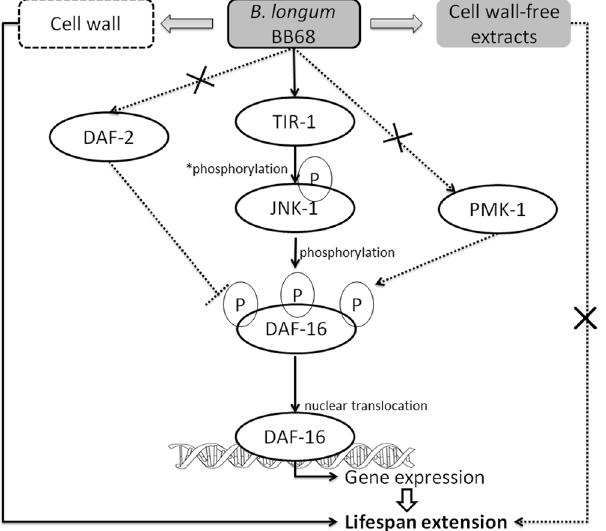
Figure 4. Mechanism by which BB68 affects the longevity of C. elegans . BB68 increased the longevity of nematodes by activating the TIR-1 – JNK-1 – DAF-16 signaling pathway, and the cell wall component of BB68 contributed to longevity. The solid arrow indicates activation observed in this study. A dashed line with an ‘ × ’ indicates that no effect was observed in this study. A dashed line indicates that the test was not performed in this study. A “P” indicates a phosphorylation site. * Indicates direct or indirect